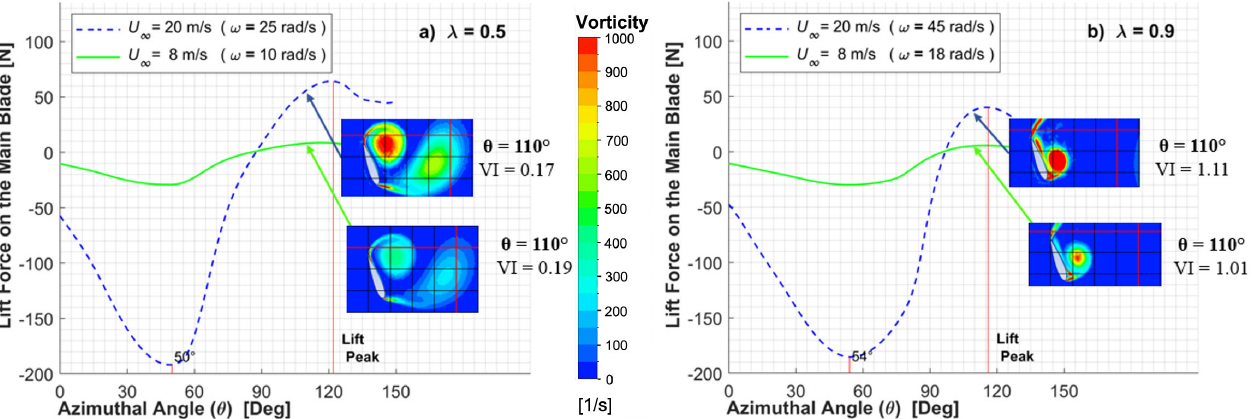
Figure 21. Lift Force and VI for Blade 1 and VI with Azimuthal Position for 𝑈 (cid:2998) = 8 m/s and 𝑈 (cid:2998) = 20 m/s at: (a) 𝜆 = 0.5 and (b) 𝜆 = 0.9, Using the 2D Model of the Present Study.